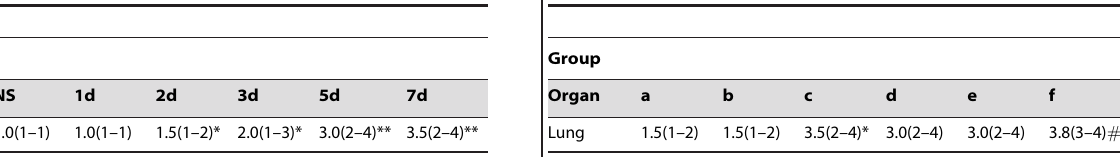
Table 1. Lung histopathological scores. Table 2. Lung histopathological